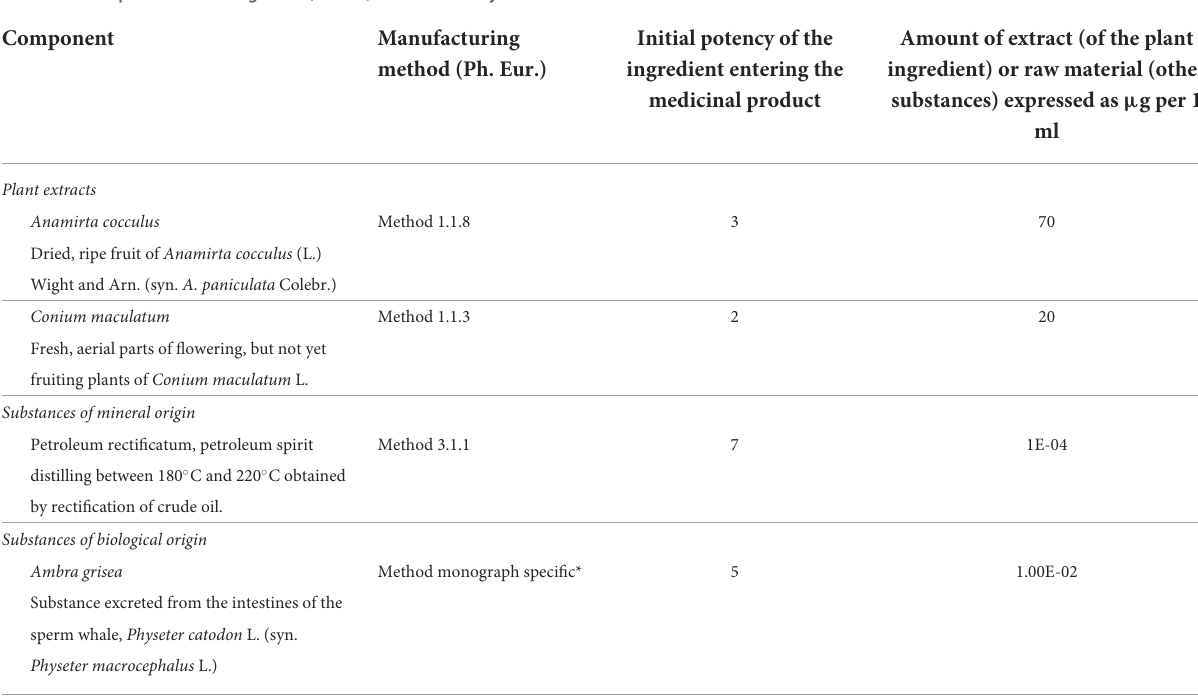
TABLE 1 Composition of vertigoheel (VH-04) solution for injection.